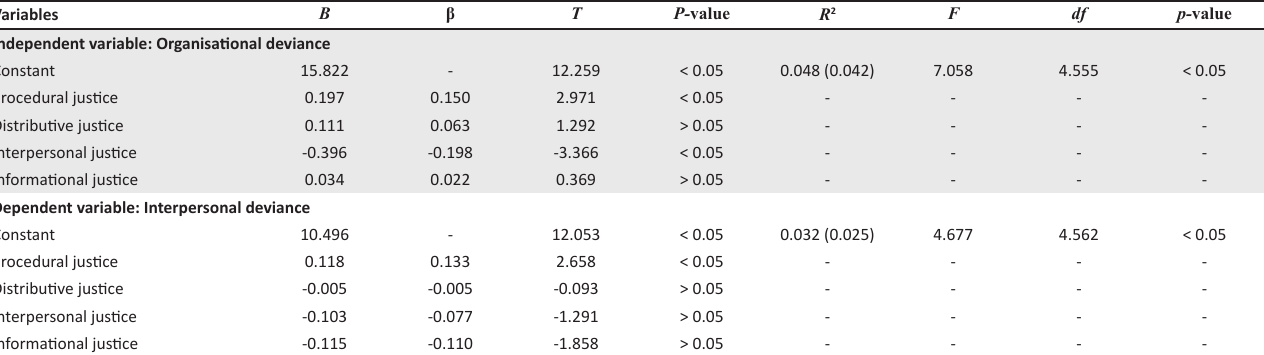
TABLE 3: Regression model summary on deviance behaviour and organisational justice.